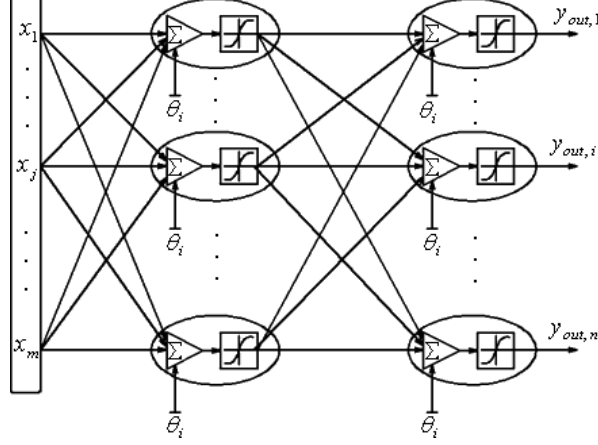
Figure 1. Architecture of the multilayer neural